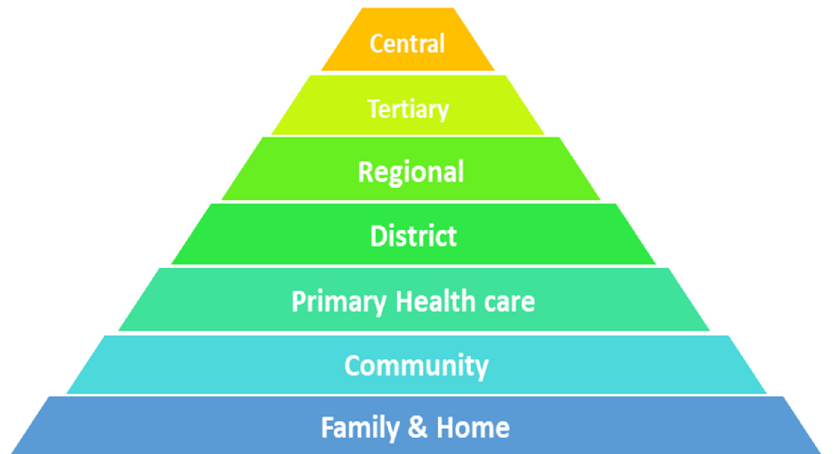
Figure 1. Organizational and Referral hierarchy of oncology and general health services in KZN Source: Kutzin & Barnum [45] .